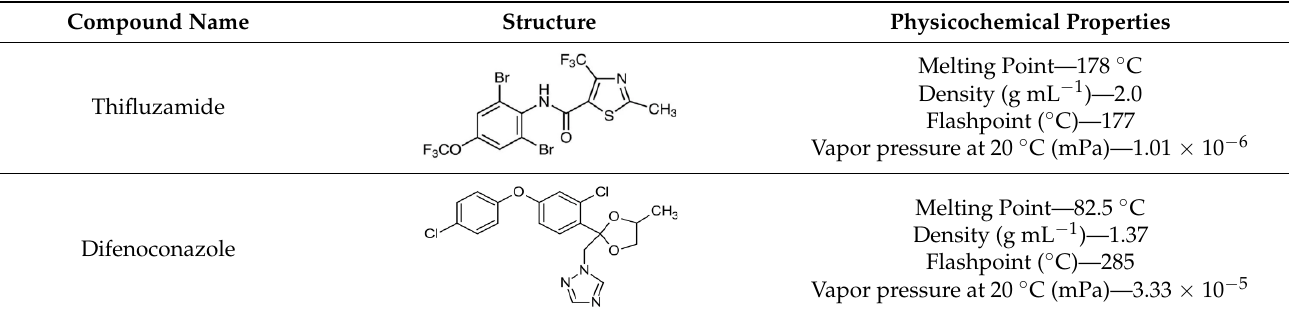
Table 1. Physicochemical Properties of Thifluzamide and Difenoconazole.